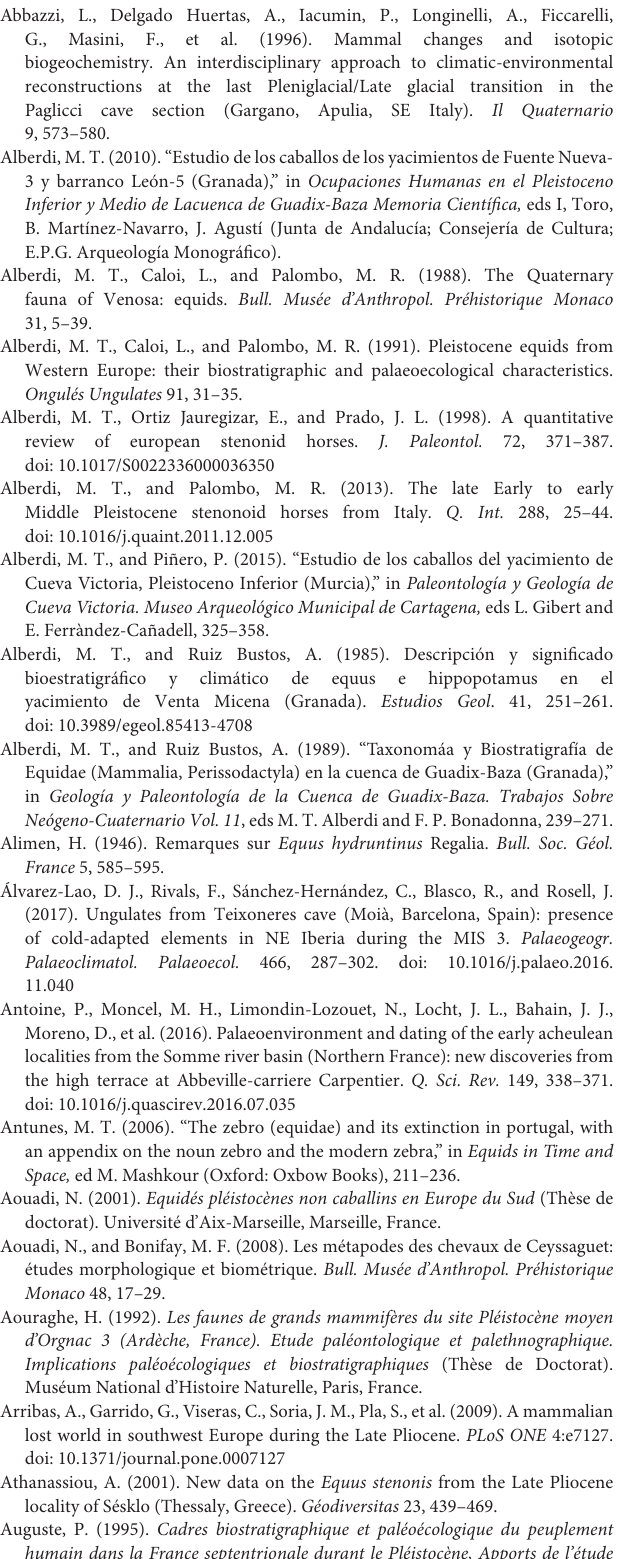
(hérault) Equus mosbachensis palustris n. ssp. Gallia Préhistoire 23, 233–281. doi: